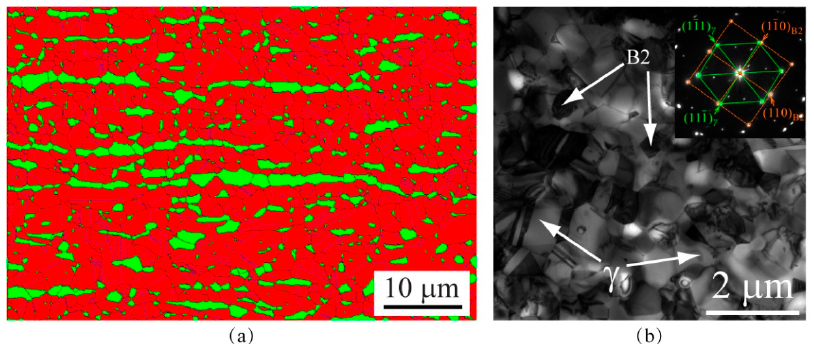
Figure 2. ( a ) Electron back-scattered diffraction (EBSD) phase image and grain morphology for the high specific strength steel (HSSS) after annealing at 900 ◦ C for 15 min (The red color stands for γ -austenite phase, and the green color stands for B2 phase). ( b ) TEM image showing the microstructures of γ -austenite phase and B2 phase after annealing at 900 ◦ C for 15 min. The indexed selected area diffraction pattern for TEM image with electron beam closely parallel to both the [011] γ and [001] B2 zone axes is shown in the inset of Figure 2b.